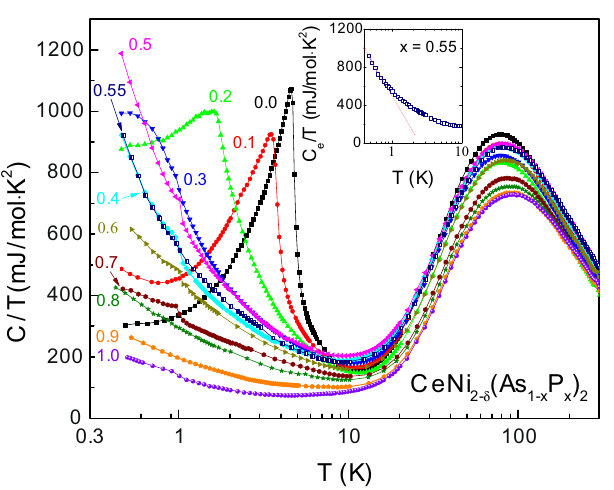
Figure 4. Temperature dependence of specific heat divided by temperature, C / T , for CeNi 2 − δ (As 1 − x P x ) 2 . Inset displays the electronic contribution C e ( T )/ T for x = 0.55 at T = 0.4–10 K. The dashed line is a linear